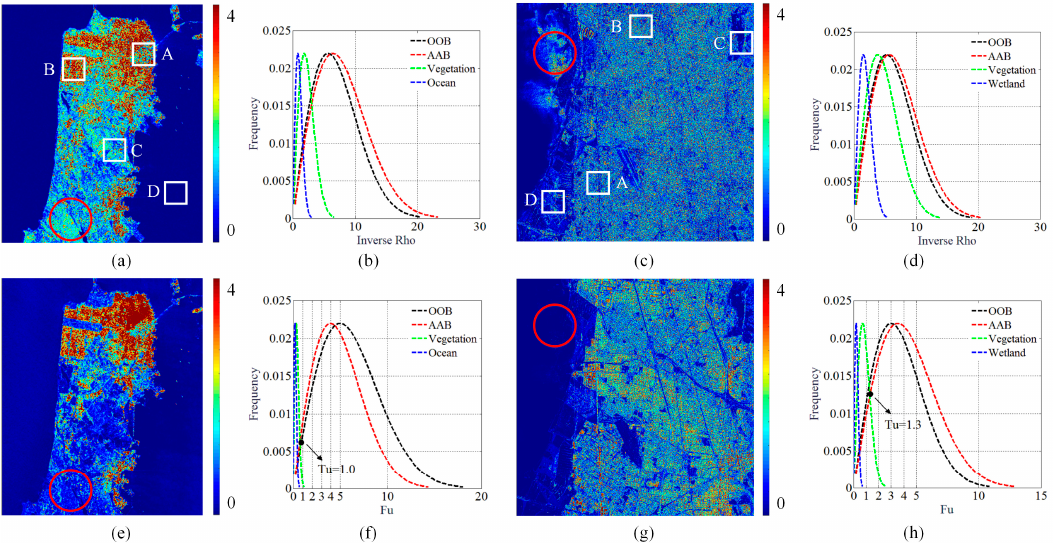
Figure 4. Magnitudes of proposed scattering feature and histograms of selected patches. ( a )–( b ) The magnitudes and histograms of 1/ (cid:12) ρ HHVV (cid:12) for GF-3, respectively. ( c )–( d ) The magnitudes and histograms of 1/ (cid:12) ρ HHVV (cid:12) for UAVSAR, respectively. ( e )–( f ) The magnitudes and histograms of F U for GF-3, respectively. ( g )–( h ) The magnitudes and histograms of F U for UAVSAR, respectively.